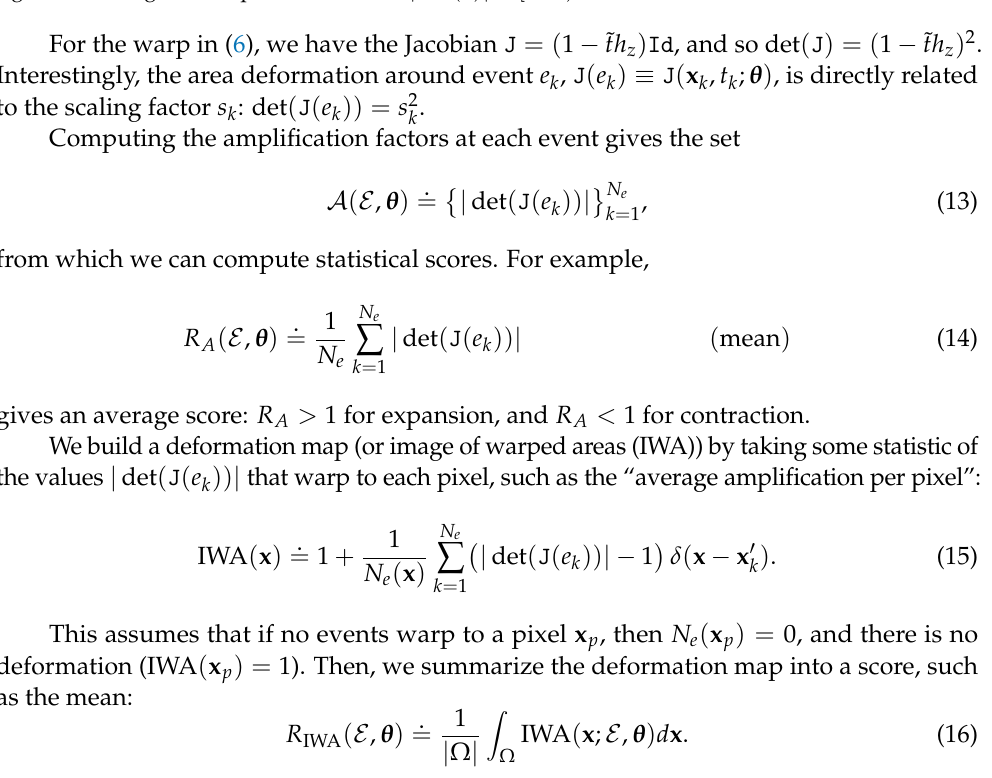
Figure 5. Area deformation of various warps . An area of dA pix 2 at ( x k , t k ) and is warped to t ref , giving an area dA (cid:48) = | det ( J k ) | dA pix 2 at ( x (cid:48) , t ref ) , where J k ≡ J ( e k ) ≡ J ( x k , t k ; θ ) (see (12)). From left to k right, increasing area amplification factor | det ( J ) | ∈ [ 0, ∞ )